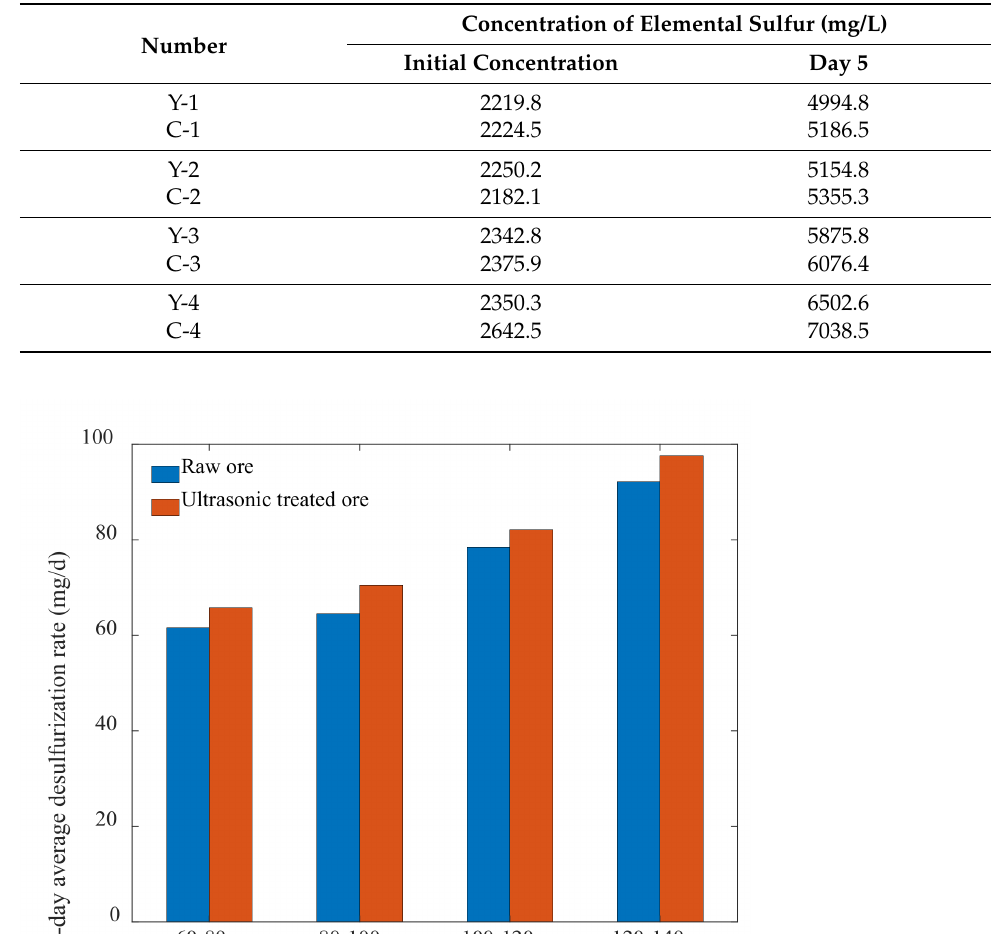
Table 10. Results of the experiment on the effect of particle size on desulfurization rate.